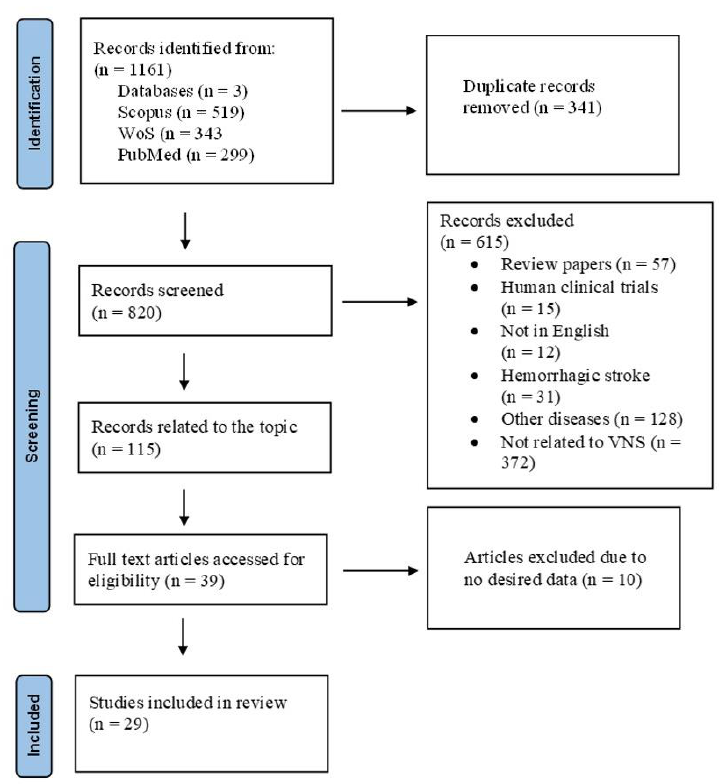
Figure 1. The systematic review process. The flow diagram outlines the search and selection process that was applied in the systematic review of published studies. All review steps were based on the PRISMA guidelines. Records (n) relate to the number of database searches, the number of abstracts screened, and the number of full texts obtained.